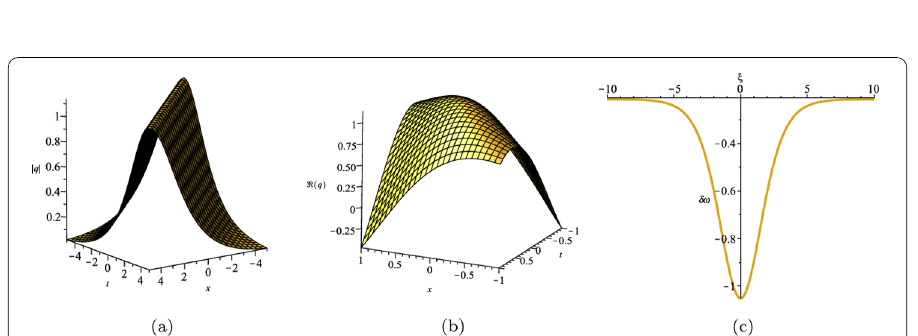
Figure 6 Chirped bright soliton solution (41) with a 1 = 3, a 2 = –4, b = 2, α = –6, λ = 6, μ = 1, ν = 1, σ = 2, Ω = –2. ( a ) Modulus. ( b ) Real part. ( c ) Corresponding chirp